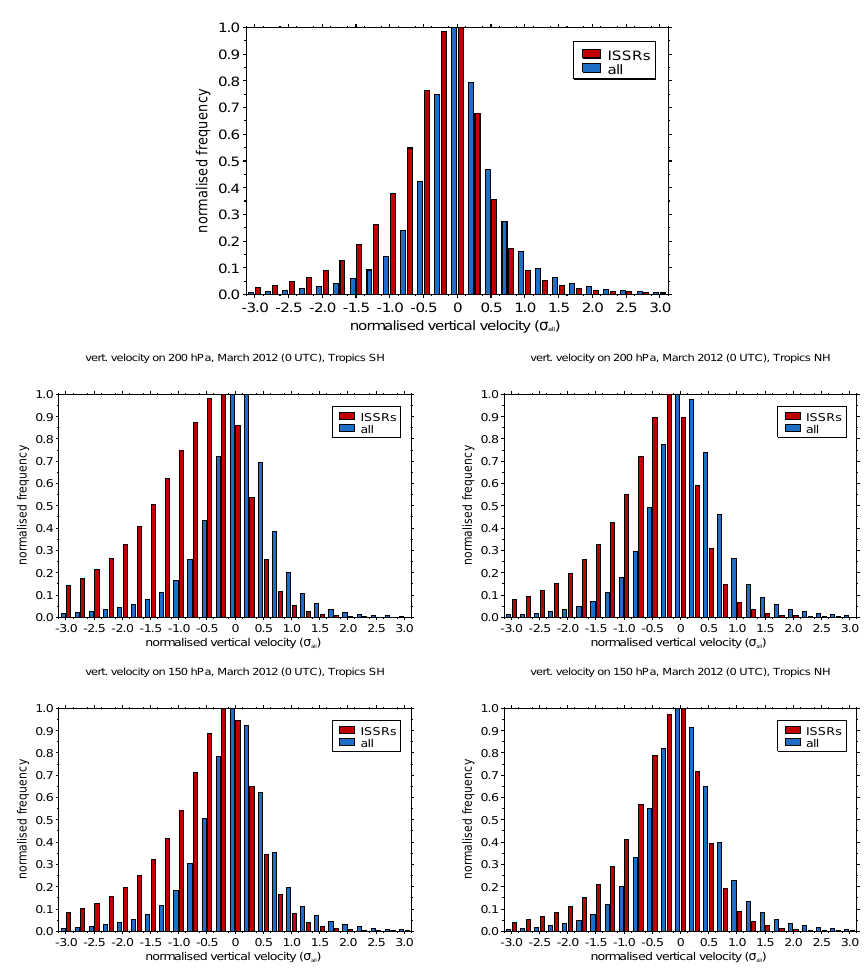
Fig. 3. As Fig. 1, but for vertical velocity, ω = d p/ d t . Negative values mean upward Fig. 3. As figure 1, but for vertical velocity, ω = dp/dt . Negative values mean upward motion.